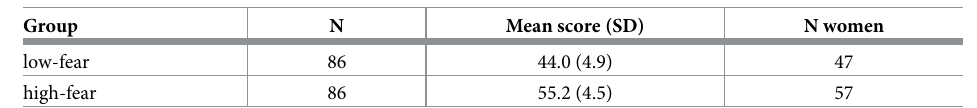
Table 2. Description of the